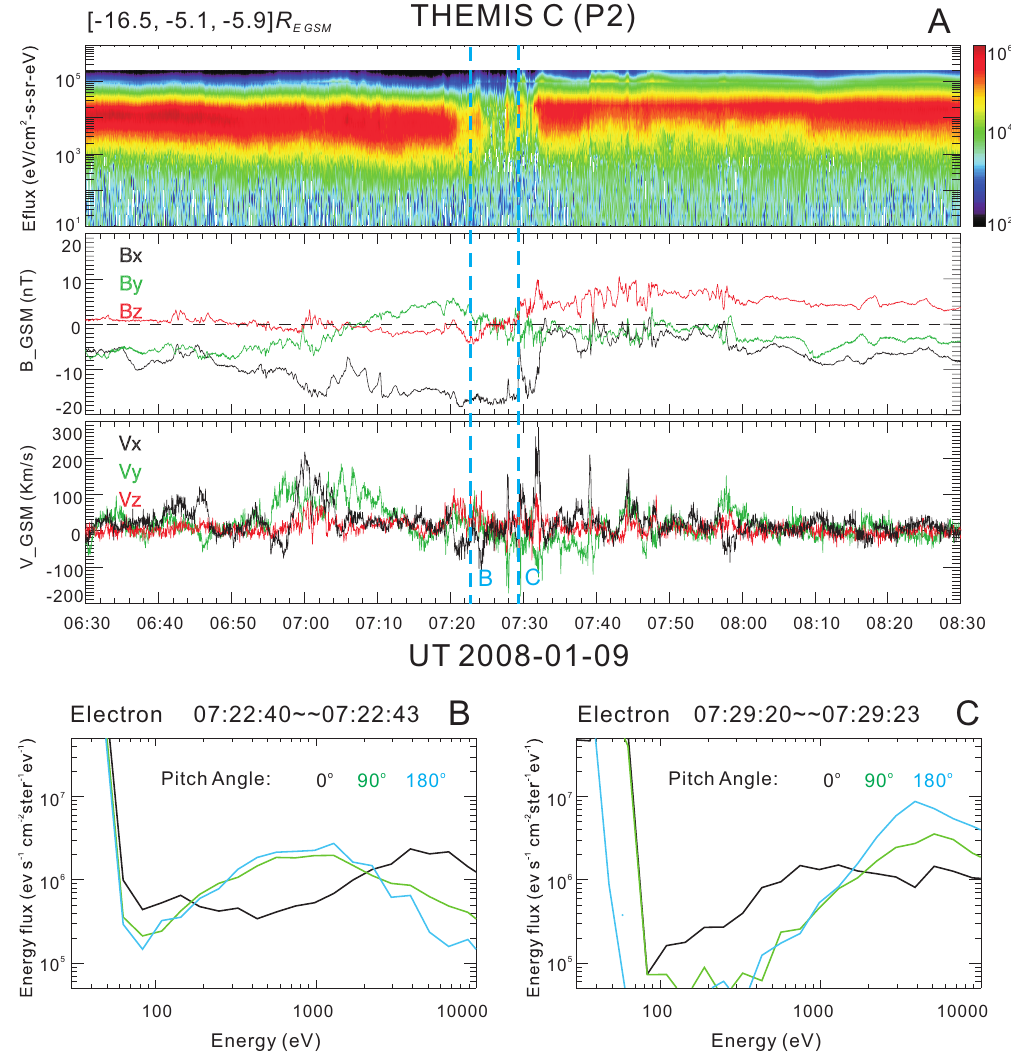
Fig. 3. Detailed observation at P2: panel (A) shows the ion spectra from 10eV to 50keV, the magnetic field and the ion bulk velocity. Panels (B) and (C) give the energy flux spectra of electrons along (0 ◦ ), opposite (180 ◦ ) and perpendicular (90 ◦ ) to the magnetic field for the times marked by the cyan vertical dashed lines in panel (A)